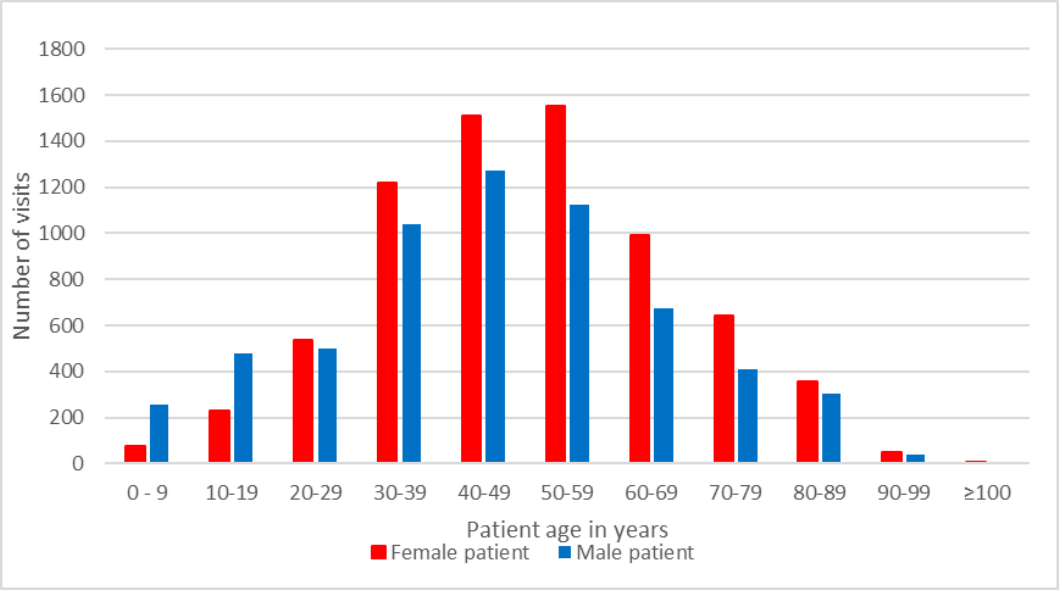
Figure 1. Number of outpatients visits by patient age and gender.